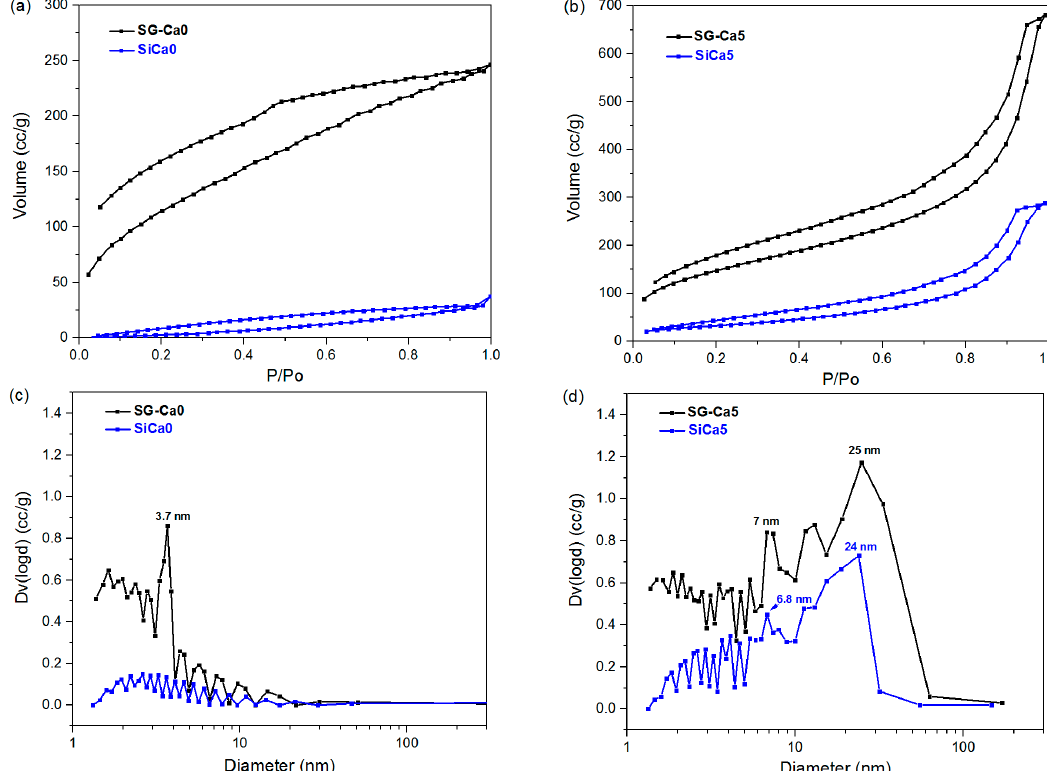
Figure 5. N 2 sorption isotherms of SG-Ca0 and SiCa0 in ( a ), SG-Ca5 and SiCa5 in ( b ) and the BJH desorption particle size distribution calculated for SG-Ca0 and SiCa0 in ( c ) and SG-Ca5 and SiCa5 in ( d ). Table 4. BET specific surface area (SSA) values calculated for xerogel samples and silicon oxycarbide samples from N 2 sorption isotherms.